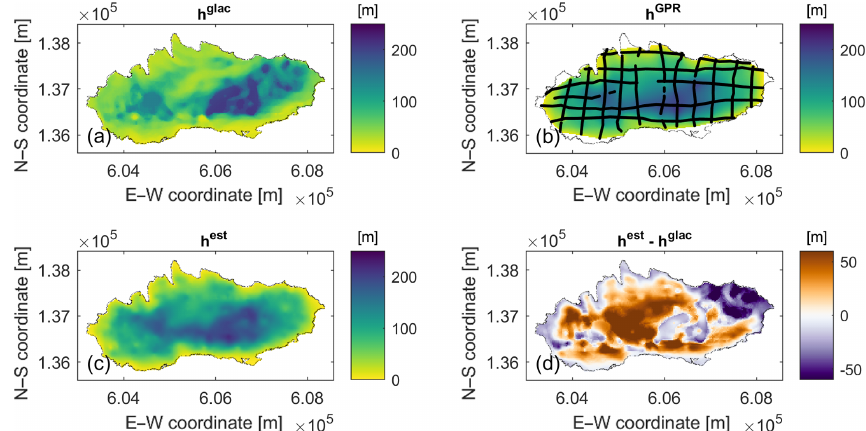
Figure 3. Results from Glacier de la Plaine Morte using only (a) glaciological constraints or (b) GPR constraints. Panel (c) shows the GlaTE inversion result, and panel (d) depicts the difference between the results shown in panels (a) and (c) . Colors indicate ice thickness or ice thickness differences. Available thickness data obtained from GPR profiles are marked with black lines in panel (b) .